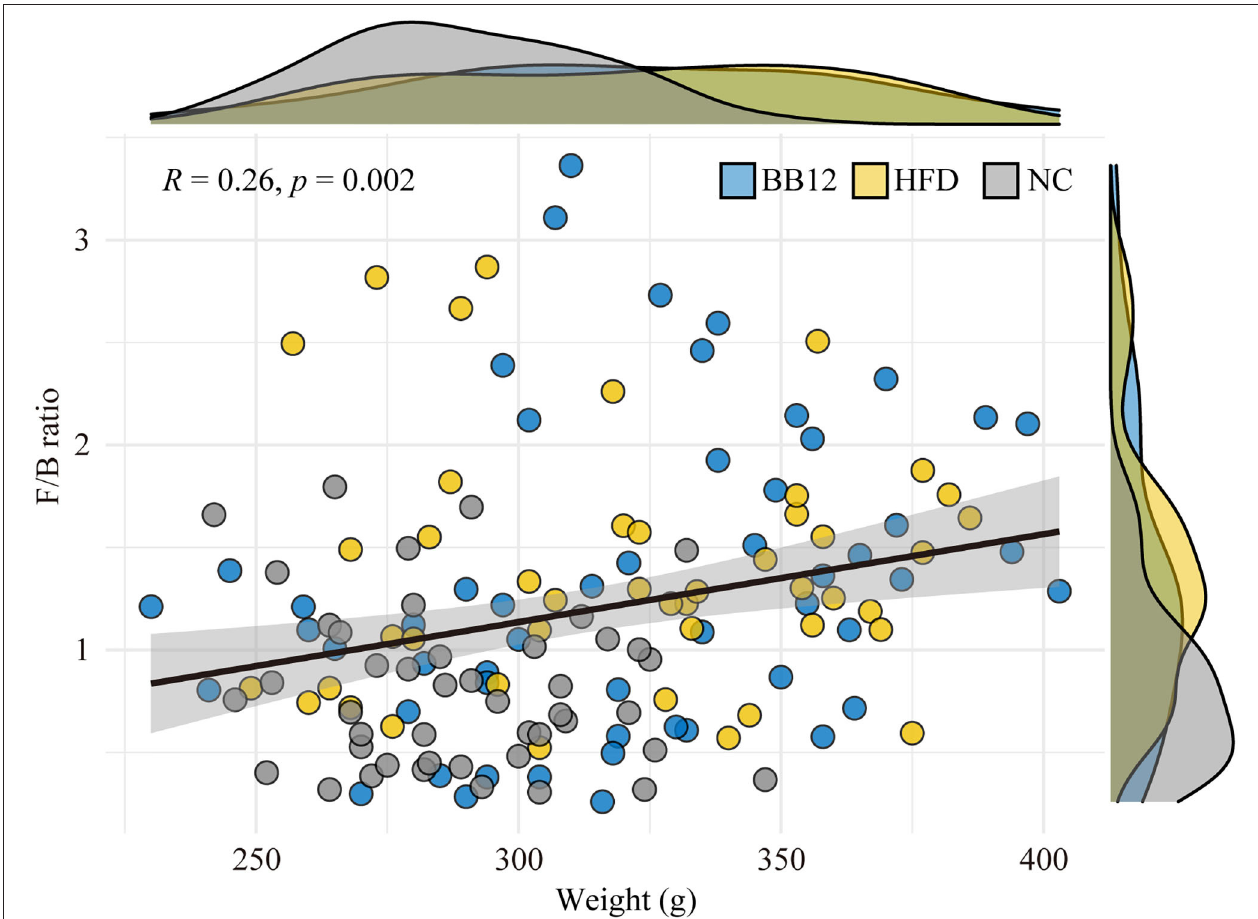
FIGURE 3 | Correlation analysis between body weight and Firmicutes/Bacteroidetes ratio. The graph shows arbitrary data for the NC group (gray circles and density curves), the HFD group (light yellow circle and density curves), and the BB-12 group (light blue circle and density